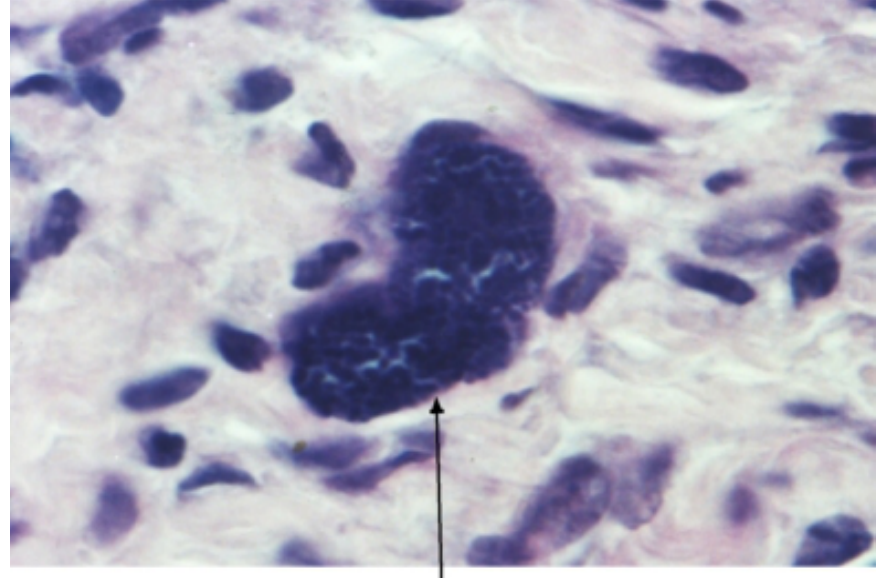
FIGURA 3 - Grumos bacterianos no citoplasma de um macrófago (HE - 1.000 x)